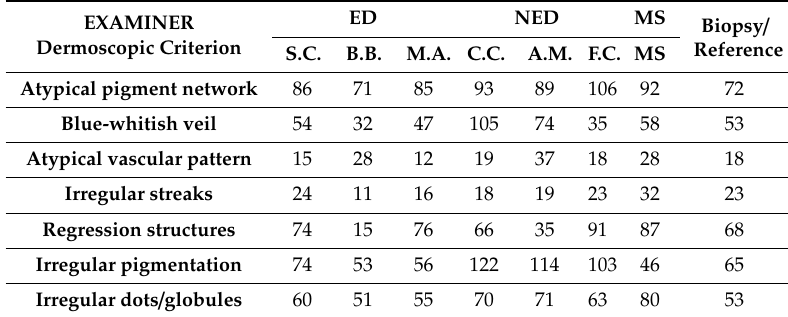
Table 4. Comparison of detection results by expert (ED) / non-expert (NED) dermatologist groups and automatic measurement system (MS).